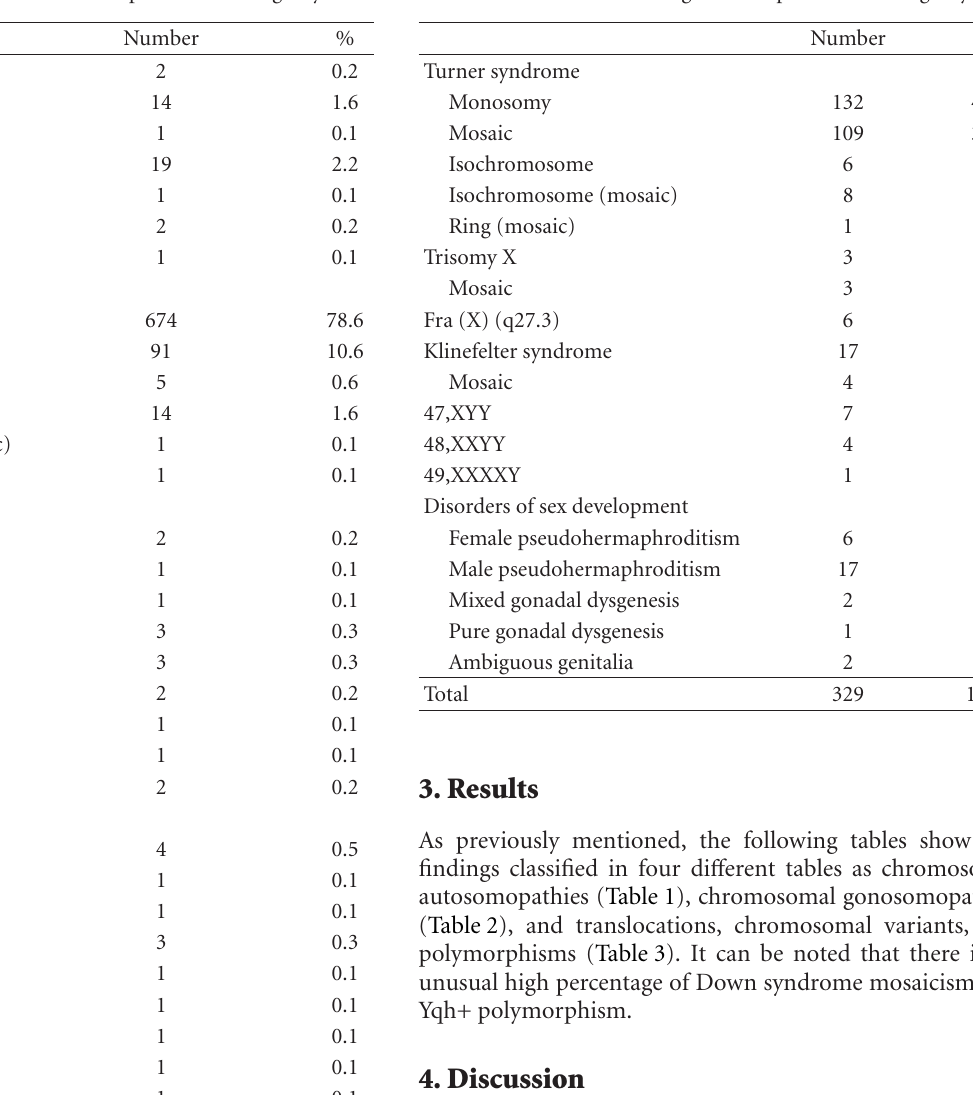
Table 1: Chromosomal autosomopathies in the registry. Table 2: Chromosomal gonosomopathies in the